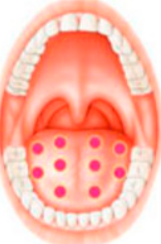
Figure 3. PBM treatment area for the management of taste alteration [19].